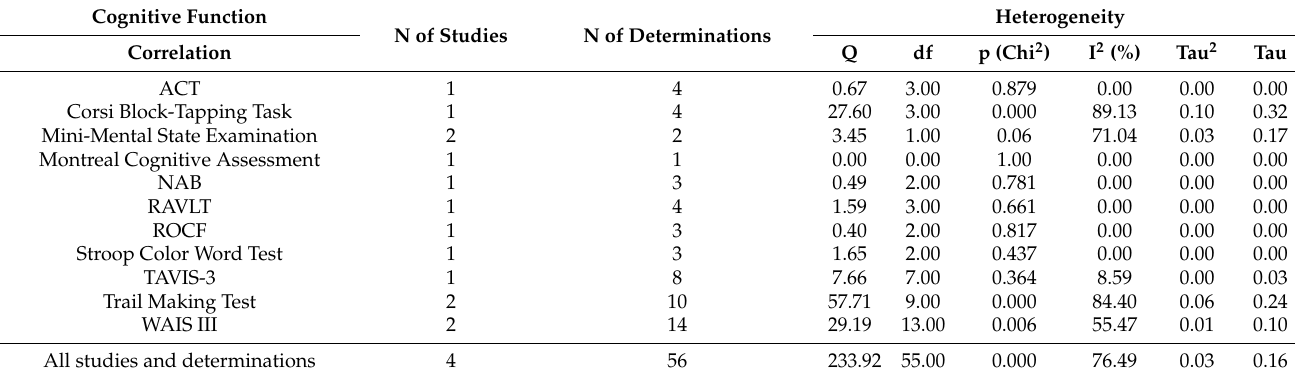
Table 3. Correlation between cognitive function and exposure to Mn. Overall heterogeneity and as a function of the cognitive test